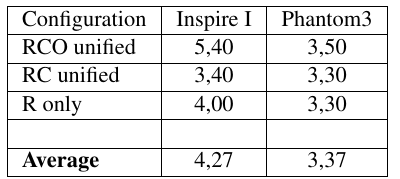
Table 2. Total mean error [cm] for two different UAV camera systems under various block